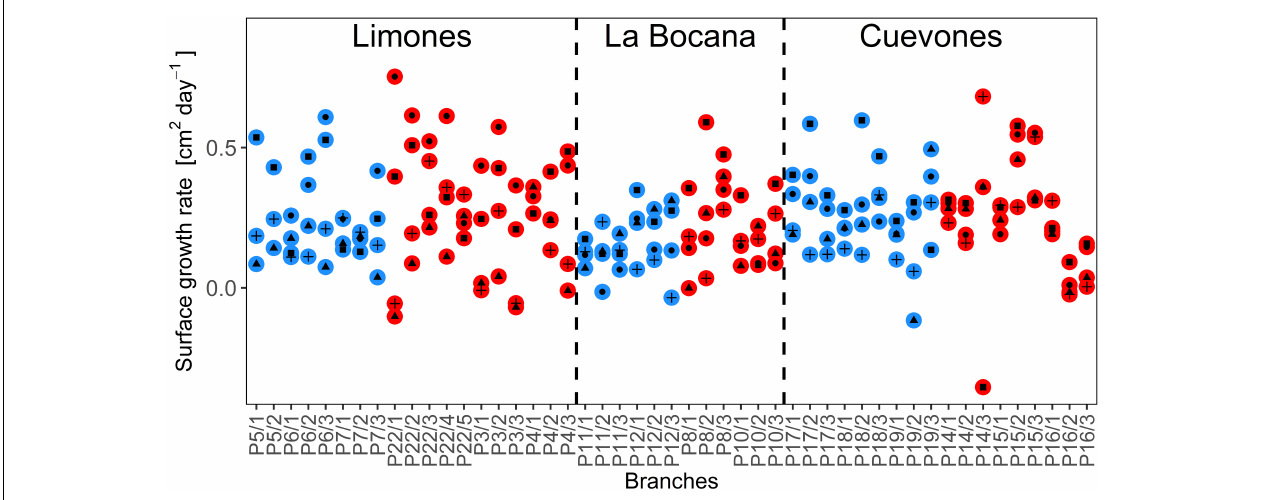
FIGURE 4 | The surface growth rates (cm 2 day − 1 ) of each branch that was measured at the three sampling sites during the 4 months of the study, for apparently healthy (AH, blue circles) colonies and those with partial mortality (PM, red circles). Within the colored circles, black circles represent the rates for March, triangles for April, squares for May, and plus signs for